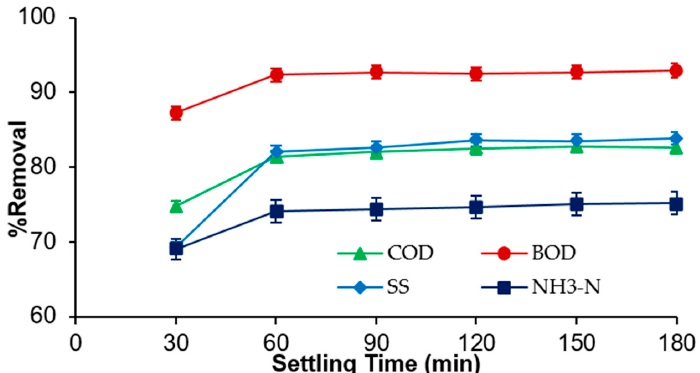
Figure 4. Influence of sedimentation time on the removal of COD, BOD, SS, and NH 3 from SRPE